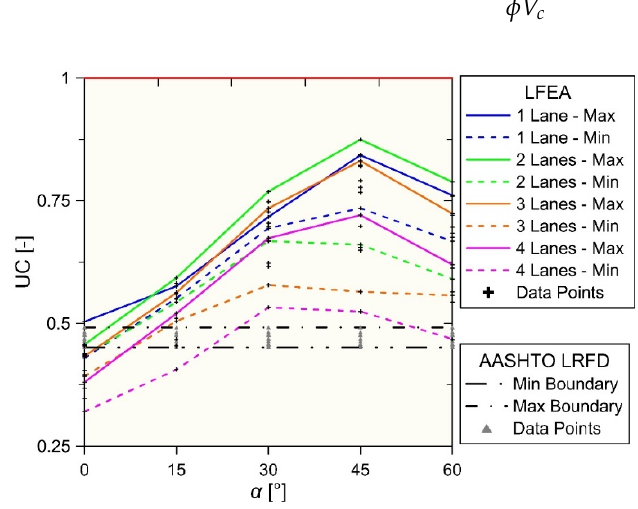
Figure 11. Relation of shear demand to concrete shear capacity. Continuous lines show the upper bound values determined from LFEA for the case study bridges of the same span length, and dashed lines show the lower bound. Dash- dotted horizontal lines show the maximum and minimum boundaries for the AASHTO LRFD UC. The data points indicate specific case study bridges. The horizontal line at UC = 1 signals the point in which shear reinforcement is necessary to fulfill the AASHTO LRFD design provisions for shear